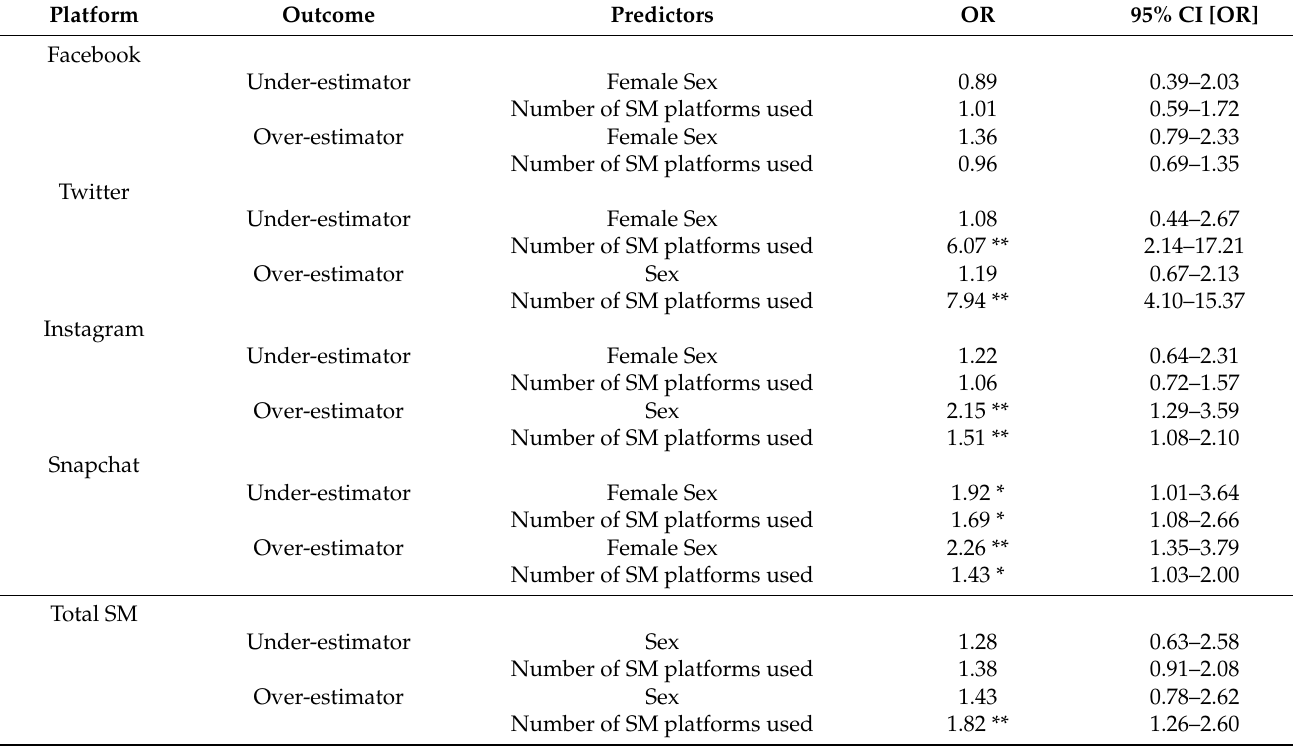
Table 3. Multinomial regression models predicting the odds of self-report classification (relative to Accurate) for each SM platform as a function of participant sex and total number of SM platforms